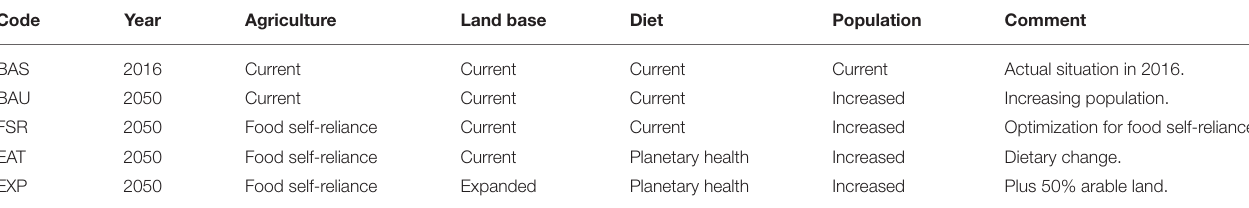
TABLE 1 | Overview of the year 2016 baseline and the four food system scenarios for 2050 considered in this study.